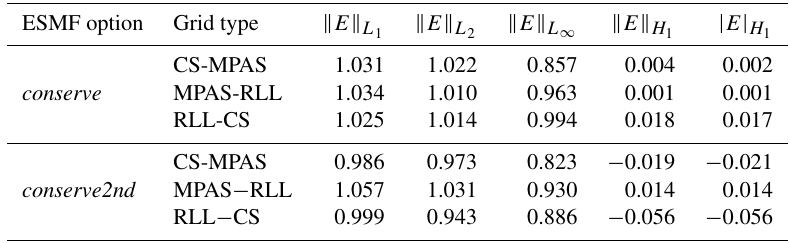
Table 2. ESMF: convergence rates for the A NALYTICAL F UN 1 field on all mesh types.